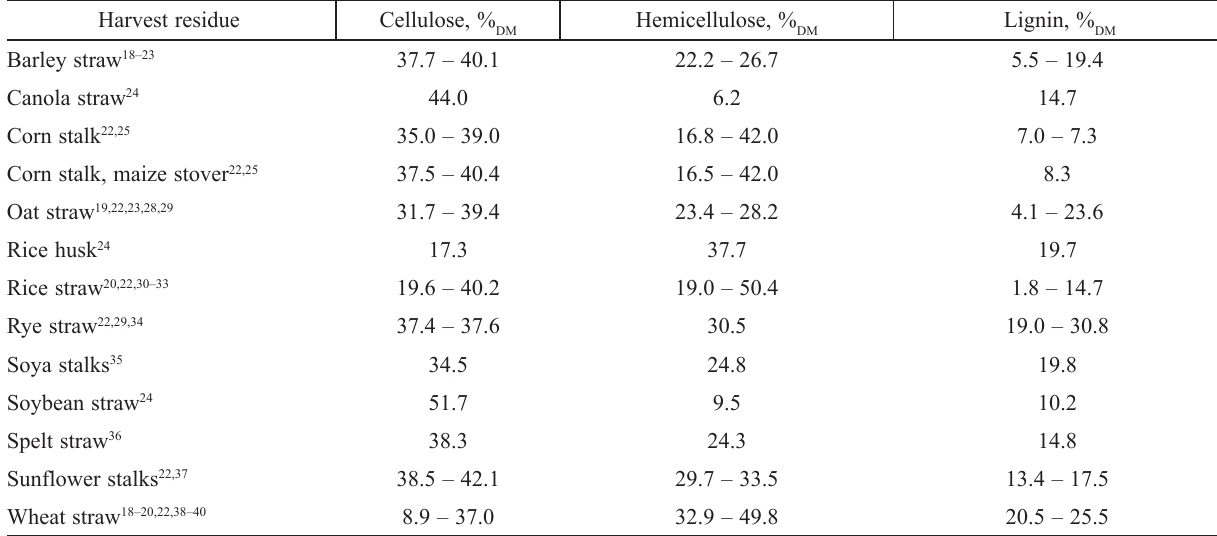
Table 1 – Chemical composition of different harvest residues Harvest